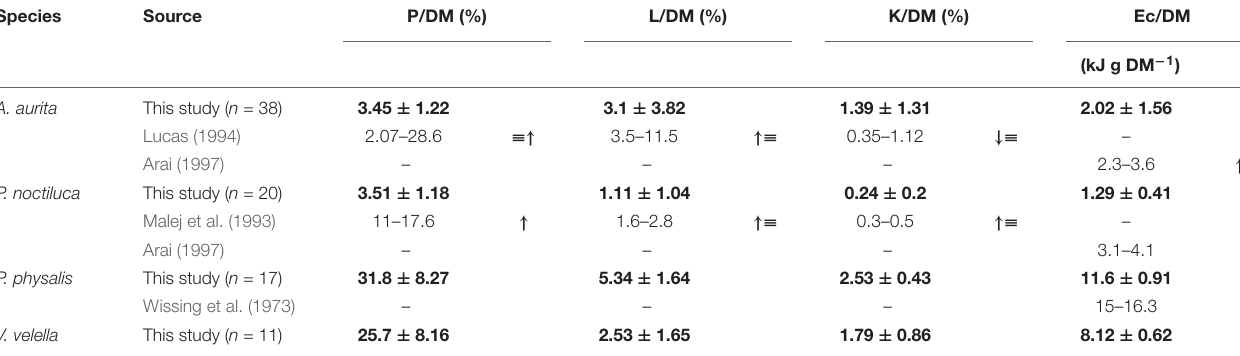
TABLE 2 | Protein (P), Lipid (L), Carbohydrate (K) and energy content (Ec) per dry mass (DM) for each species as mean ± SD. Species